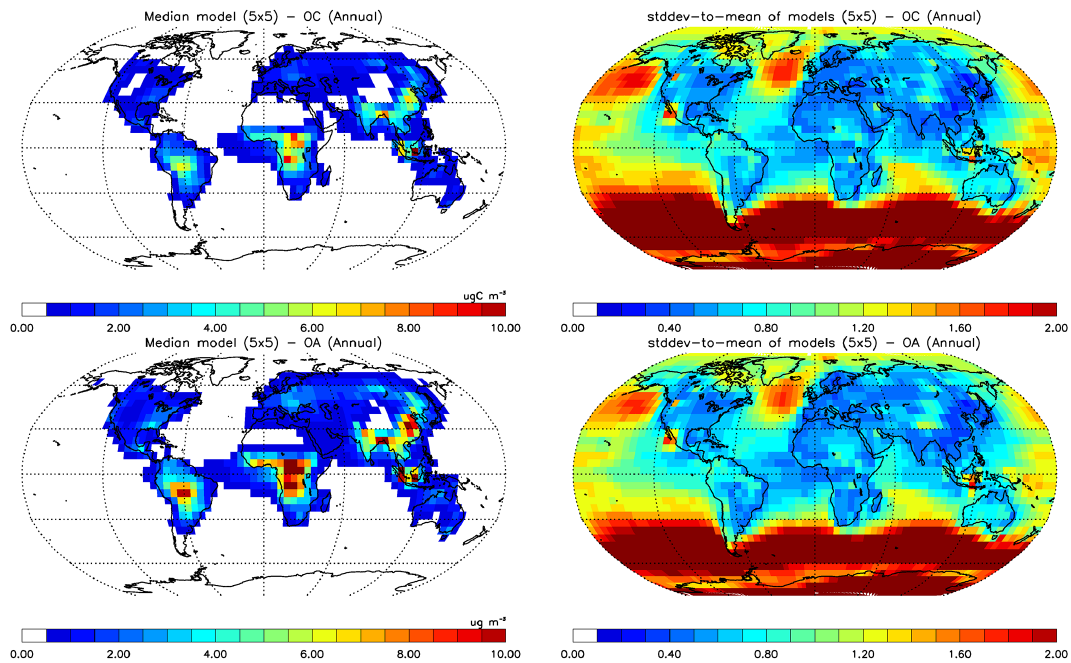
Figure 7. Annual mean of the median model surface air concentration (left) and model diversity (right), defined as the standard deviation of the models over their mean, for OC (top) and OA (bottom) on a 5 ◦ × 5 ◦ degree